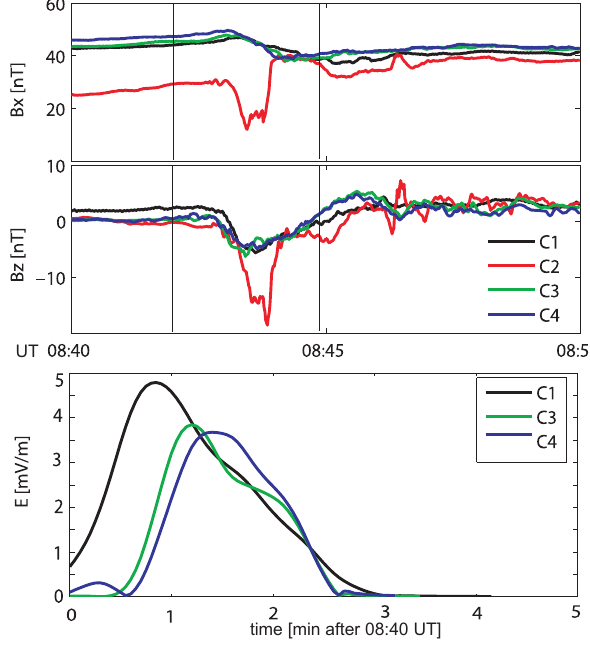
Fig. 31. The reconnection electric field reconstructed from Cluster observations on 26 September